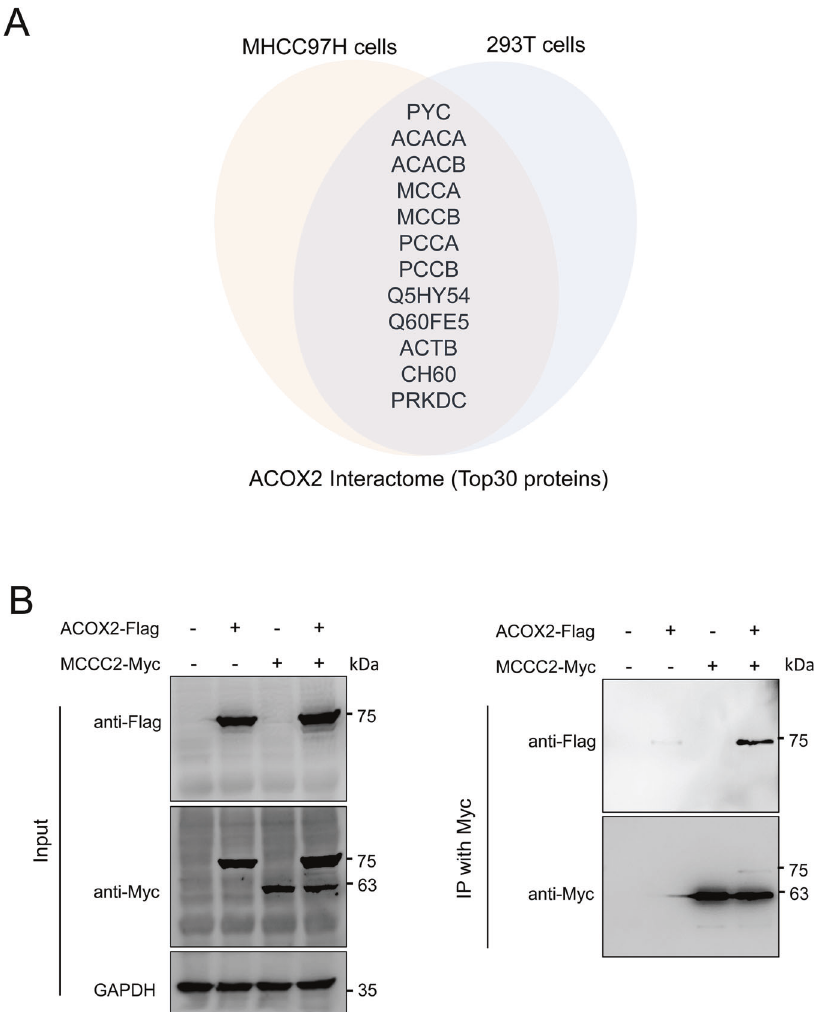
Fig. 2 Acox2 interacts with methylcrotonoyl-CoA carboxylase. A Overlapped Acox2-interacting proteins in MHCC97H and HEK293T cells by TAP-MS analysis were displayed. B Anti-Myc immunoprecipitation assays were performed in HEK293T cells overexpressing Flag-tagged ACOX2 and Myc-tagged MCCC2 constructs followed by immunoblotting with the indicated antibodies. Speci fi city of antibodies was evaluated as indicated (left panel). MCCC2 methylcrotonoyl-CoA carboxylase subunit 2, MS mass spectrometry, TAP tandem af fi nity puri fi